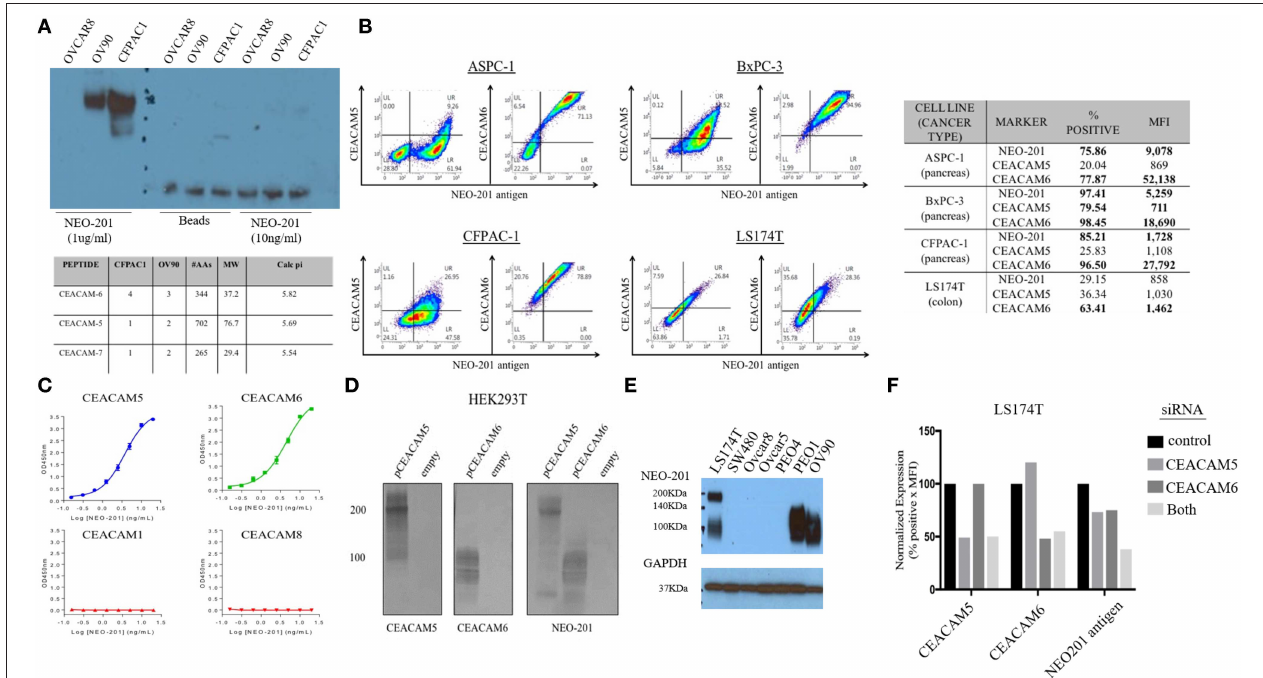
FIGURE 2 | NEO-201 binds to CEACAM 5 and 6. (A) To identify the antigen recognized by NEO-201, 100 µ g of proteins extracted from OV90, CFPAC1, and OVCAR8 was initially immunoprecipitated with 1 µ g, 10 ng of NEO-201 and protein A beads. One microgram of NEO-201 showed the best results in terms of protein isolation and was used to perform intraperitoneal (IP) injection for the protein sample that was then analyzed by mass spectrometry. Peptide suggesting the glycosylated form of CEACAM-5 and − 6 was identified as the most likely antigen recognized by NEO-201. (B) Flow cytometry analysis of the tumor cell lines ASPC-1, BxPC-3, CFPAC-1, and LS174T was performed to discriminate the native form of CEACAM5 and CEACAM6 from the NEO-201-reactive variant forms of CEACAM5 and CEACAM6. NEO-201 binding on cancer cell line model was assessed using NEO-201 Pacific Blue conjugated antibody. (C) NEO-201 binding to different forms of CEACAMs, other than 5 and 6, was measured by ELISA. (D,F) To confirm the binding of NEO-201 to CEACAM-5 and − 6, CEACAM-negative cells HEK293T were transfected with CEACAM-5 and 6 siRNA. The two proteins, which express a different molecular weight, were equally bound by NEO-201. As proof of concept, CEACAMs and NEO-201-positive cells LS174T were knock-down for CEACAM 5/6 genes, which resulted in an about 25% partial loss of NEO-201 binding when a single gene was knock-down, and a further decreased to about the 50% loss of NEO-201 binding by the combined knockdown of both CEACAMs. (E) Western blot confirmed that NEO-201 binds an antigen with two different molecular weights in cell line